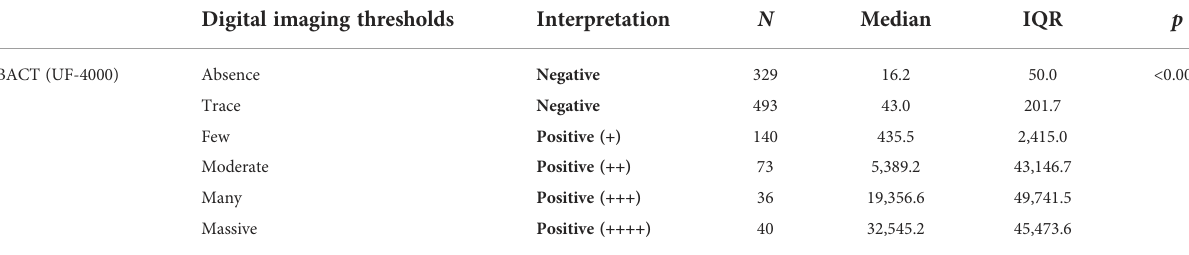
TABLE 5 Test characteristics of the two automated systems used to describe